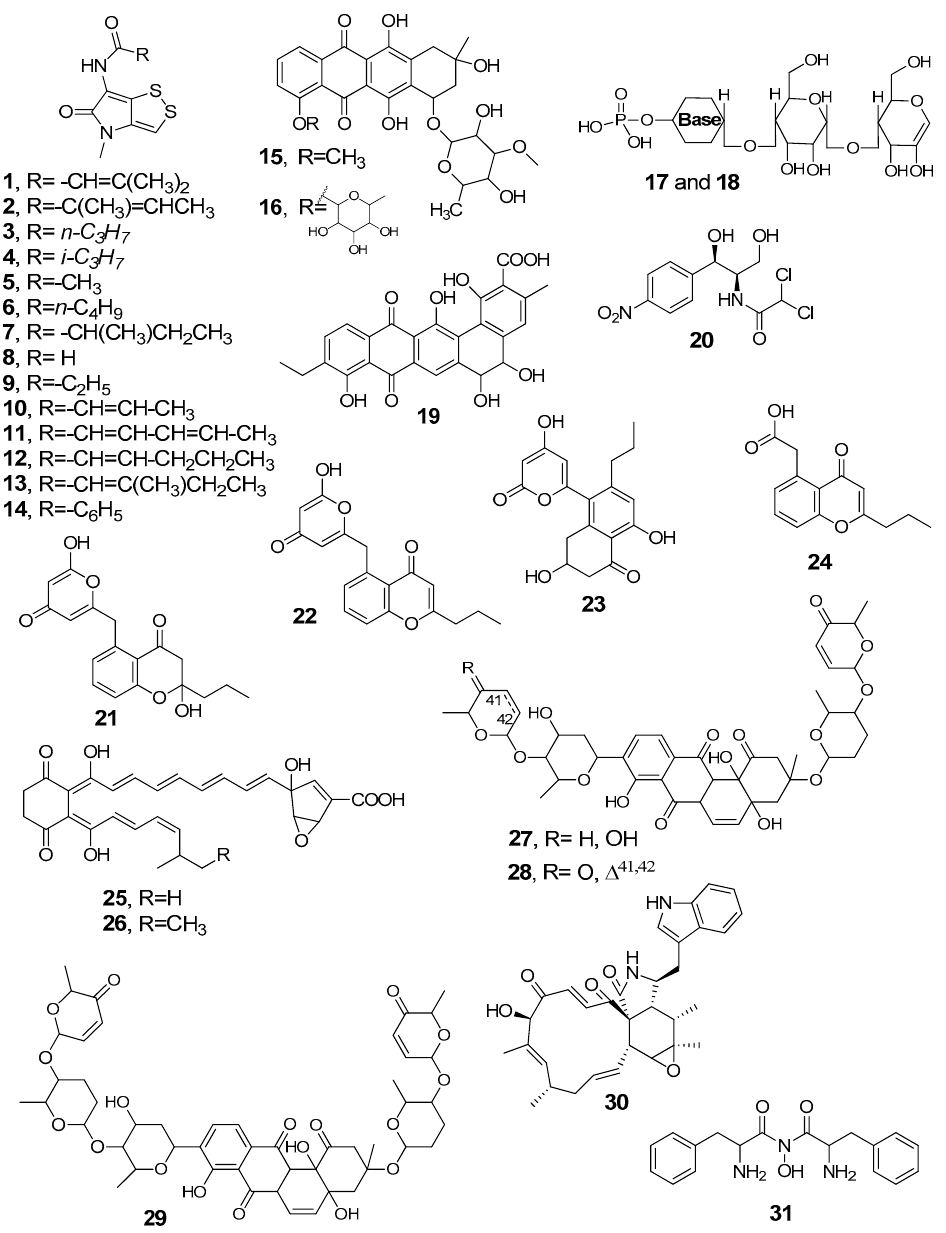
Figure 6. Molecular structures of the bioactive metabolites 1 – 31 isolated from Algerian actinobacteria: The stereochemical details are according the cited references.